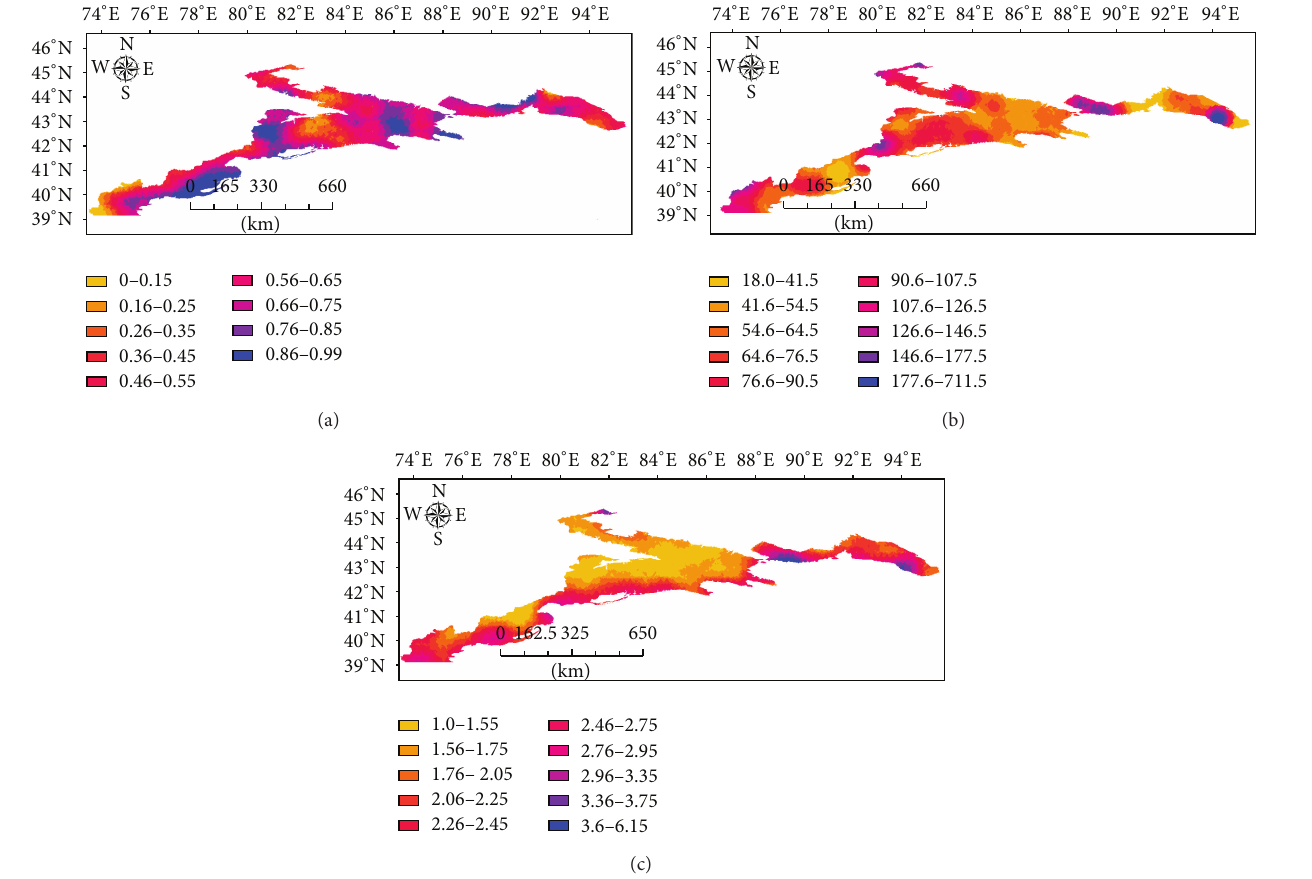
Figure 4: Spatial distribution of annual precipitation during 1998 ∼ 2007 produced by APHRODITE V1003R1 and TRMM 3B43 V7. (a) Correlation coefficient, (b) RMSE, and (c)